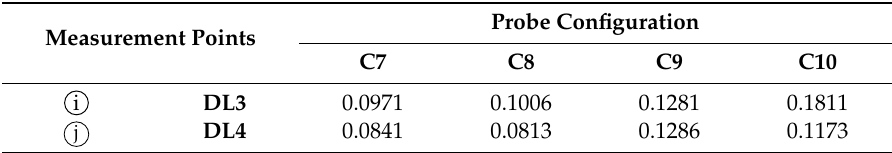
Table 4. K-S test statistic (D) to check the normal distribution of the electrical resistivity measurement for the small delamination defects of the concrete slab specimen